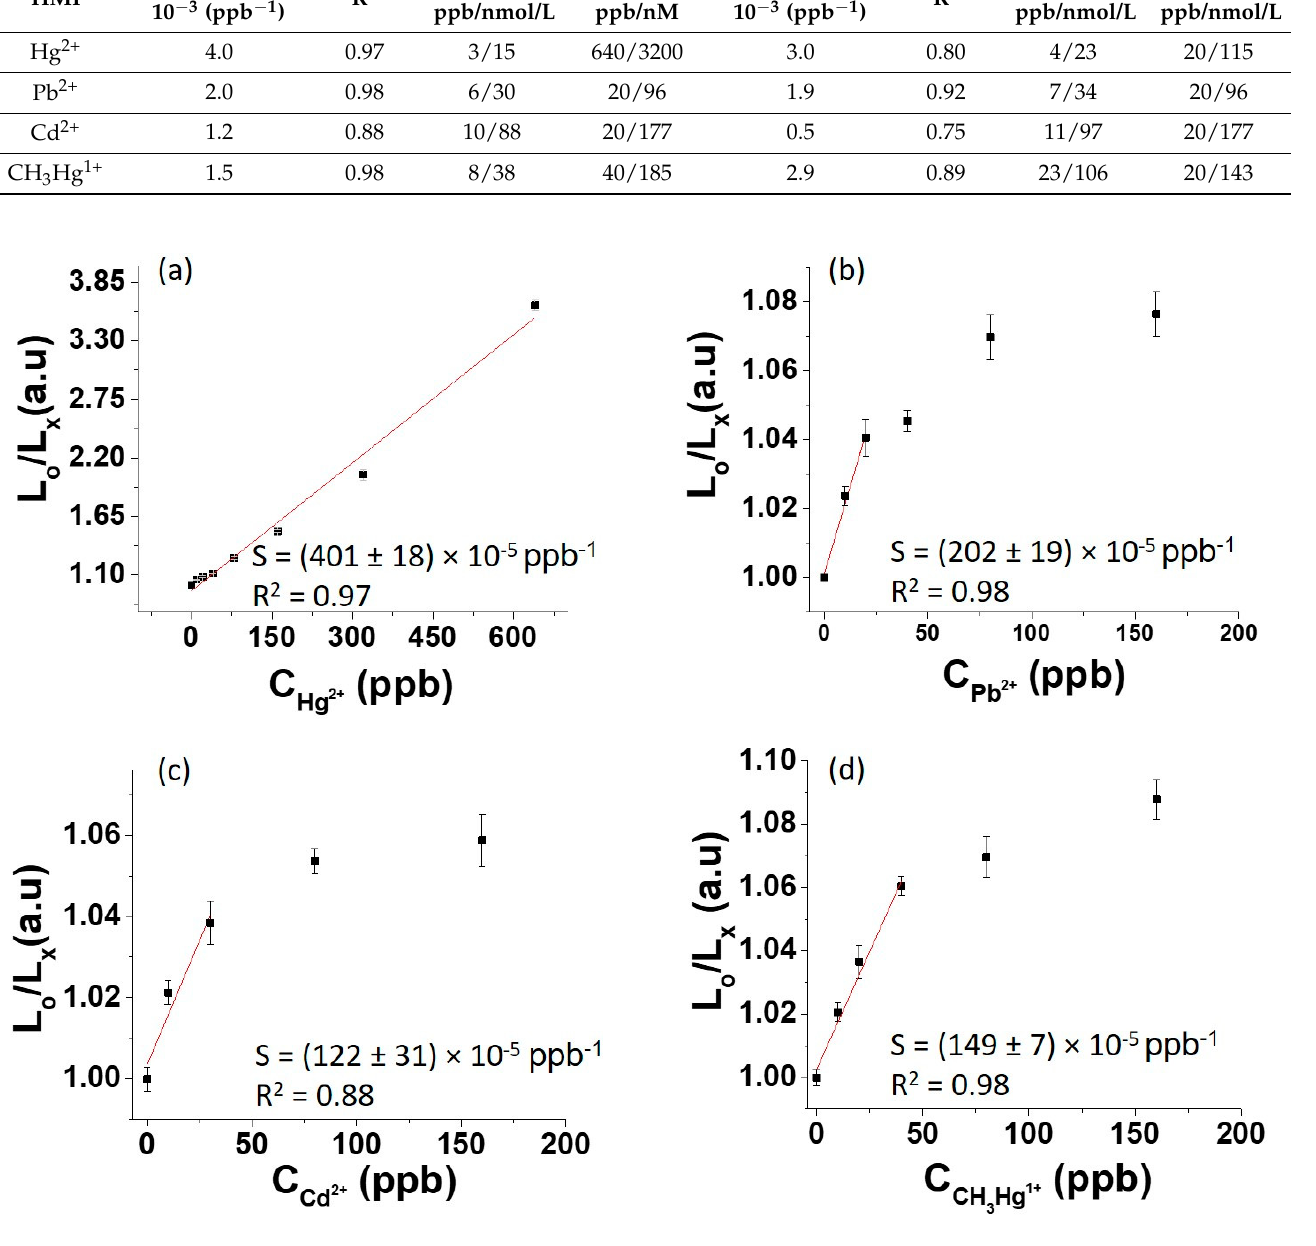
Figure 5. Behavior of L o / L x depending on the concentration of the analytes, for the emission in the UV region at 360 nm, excited at 250 nm. ( a ) Hg 2+ ; ( b ) Pb 2+ ; ( c ) Cd 2+ ; ( d ) CH 3 Hg + . The lines are the linear fits, used for the determination of the linear range and sensitivity (S) of the response. The error bars were established as authentic replicates of the measurements made on different days on different samples.